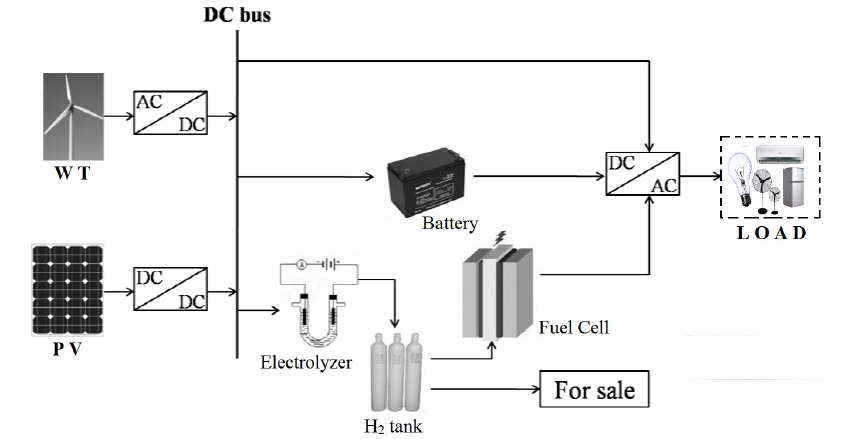
Figure 1. Basic constitution of hybrid system based on battery and hydrogen